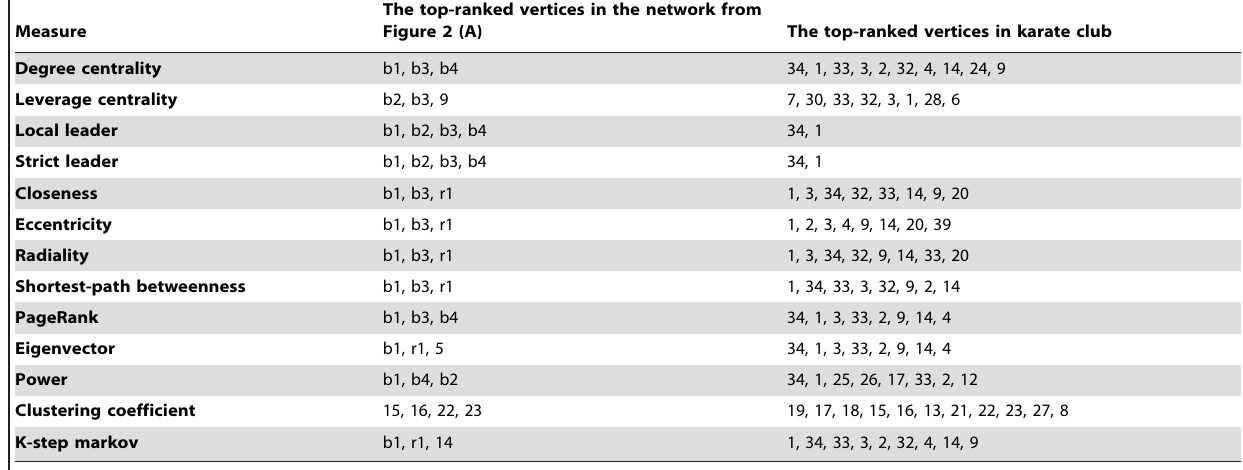
The top-ranked vertices in the network from Measure Figure 2 (A) The top-ranked vertices in karate club